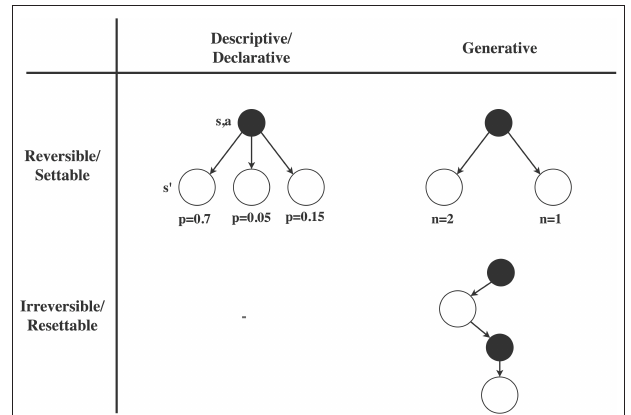
FIGURE 1 | Illustration of different types of access to the MDP transition dynamics. Rows: We may either have reversible/settable access to the MDP dynamics, in which case we can query the MDP on any desired state, or irreversible/resettable access to the MDP, in which case we have to make the next query at the resulting state, or we can reset to a state from the initial state distribution. Any type of reversible/settable access to the MDP is usually called a (known) model . Columns: On each query to the MDP dynamics, we may either get access to the full distribution of possible next states ( descriptive / declarative access), or only get a single sample from this distribution ( generative access). Note that we could theoretically think of irreversible descriptive access, in which we do see the probabilities but need to continue from the next state, but we are unaware of such a model in